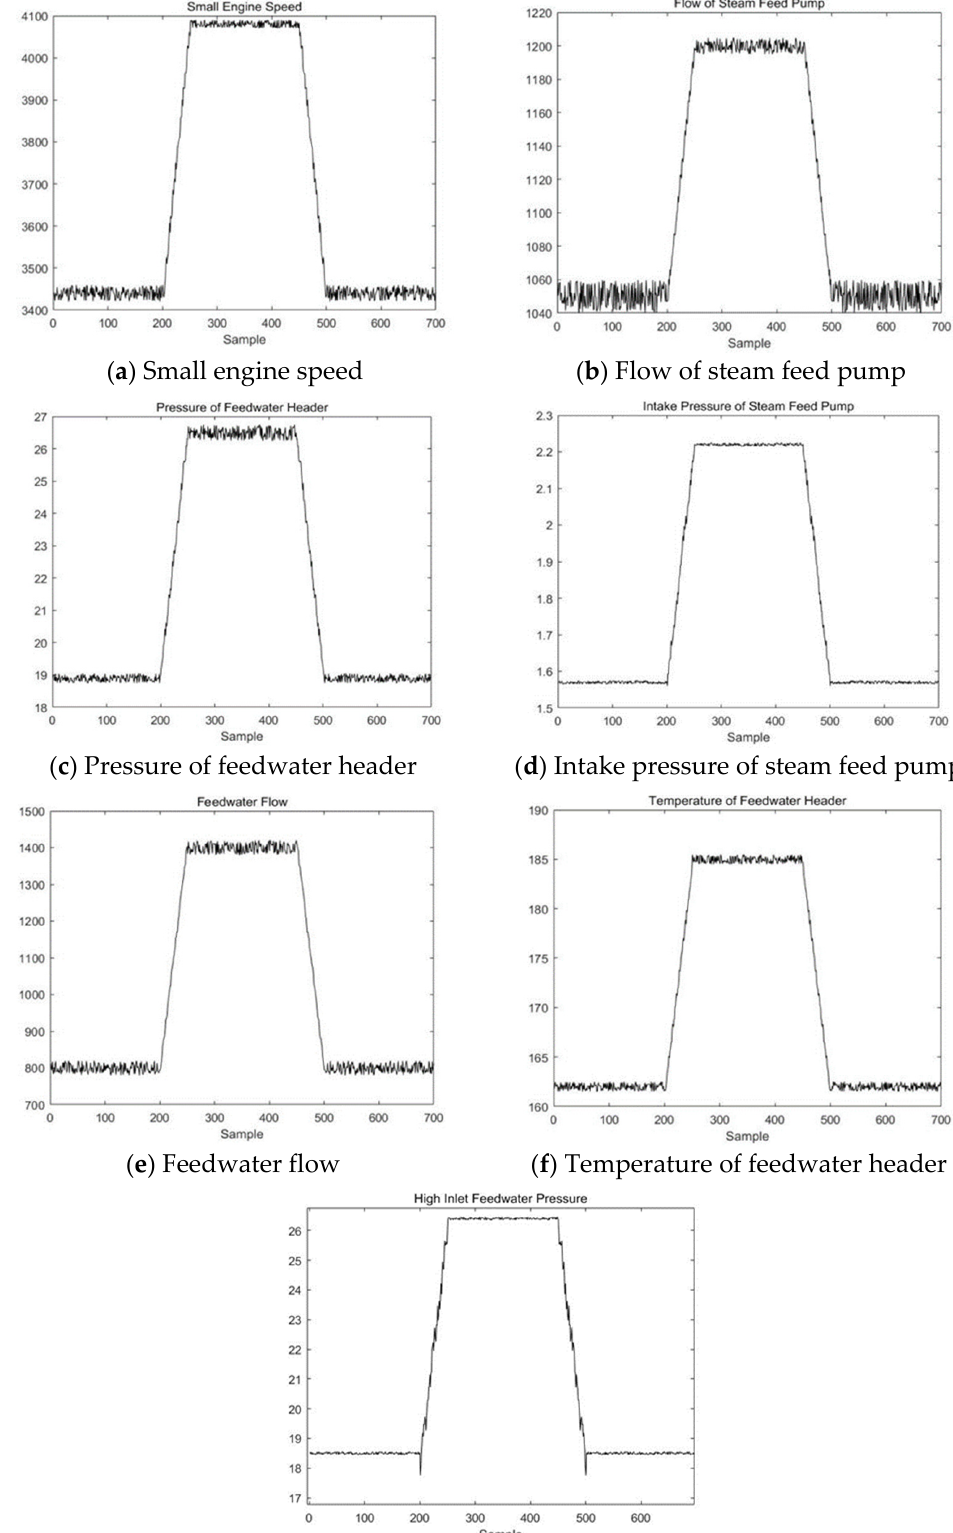
Figure 14. Schematic diagram of thermal power unit.